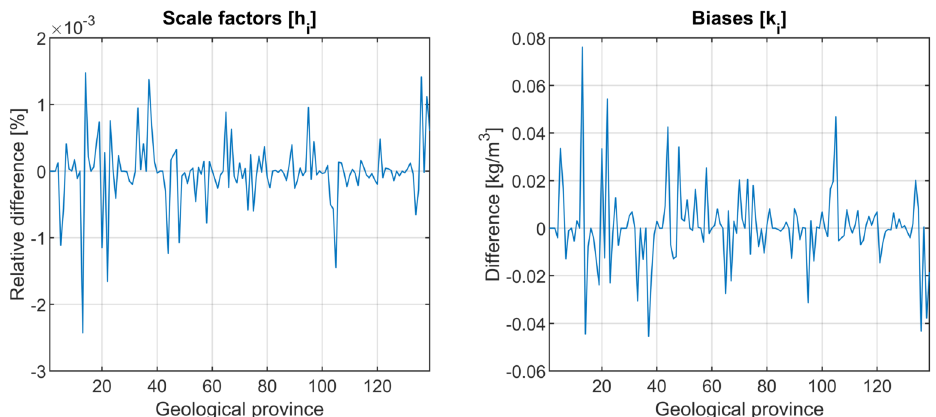
Figure 11. On the left panel , relative differences between the parameters h i estimated for each geological province changing the starting point of the iterative solution (zero undulation vs. true Moho, namely s2a and s2b, respectively). On the right panel , absolute differences between the parameters k i estimated for each geological province changing the starting point of the iterative solution (zero undulation vs. true Moho, namely s2a and s2b, respectively). In both the graphs the geological provinces are represented on the abscissa and the differences on the